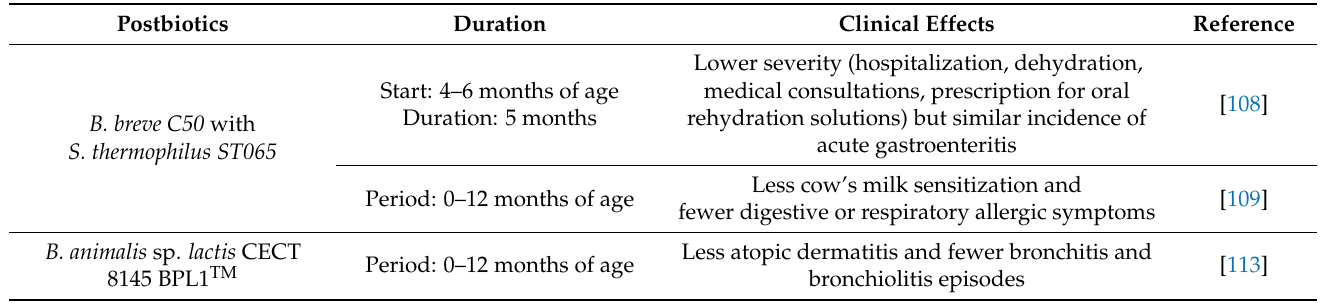
Table 4. Summary of clinical effects of postbiotics compared to control groups with non-supplemented infant formula.